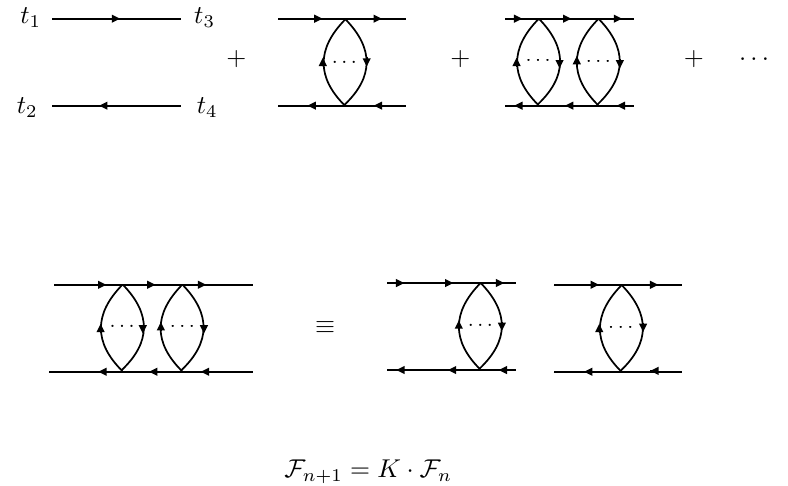
Figure 2 . A diagrammatic representation of the four point function calculation, in the large N limit. First, only the ladder diagrams contribute, as shown in the (cid:12)rst row here. Second, from the structure of the diagrams, one obtains an iterative process to generate F n +1 from F n , composing with a